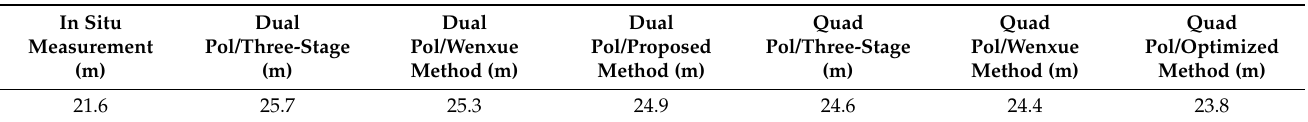
Table 1. The forest height estimation in a randomly selected pixel using different methods applied to dual and quad pol datasets.